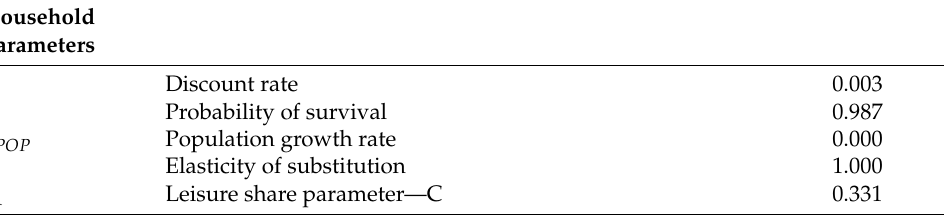
Table A3. The dynamic general equilibrium model—the structural